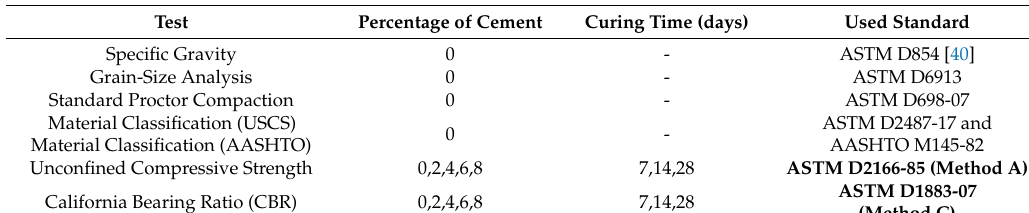
Table 5. Testing program of the treated waste sand as a base course material.